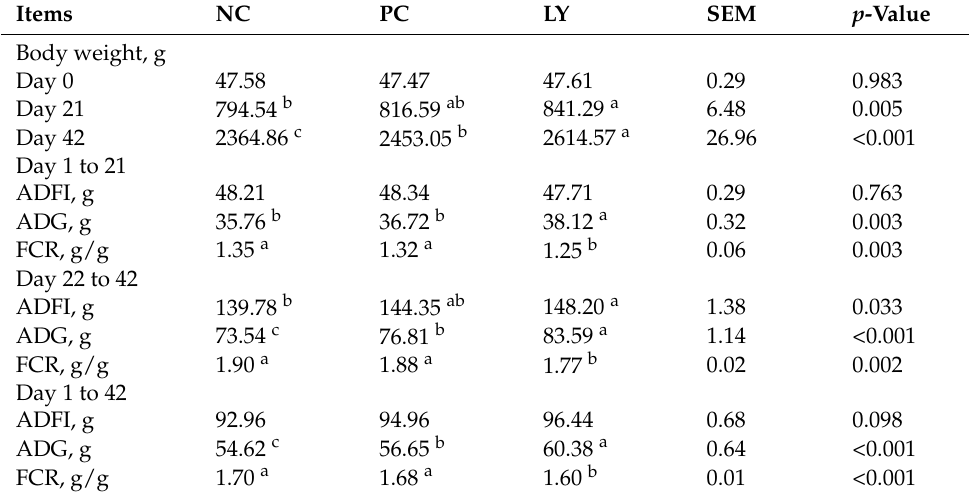
Table 2. Effect of dietary treatments on the growth performance of broilers.